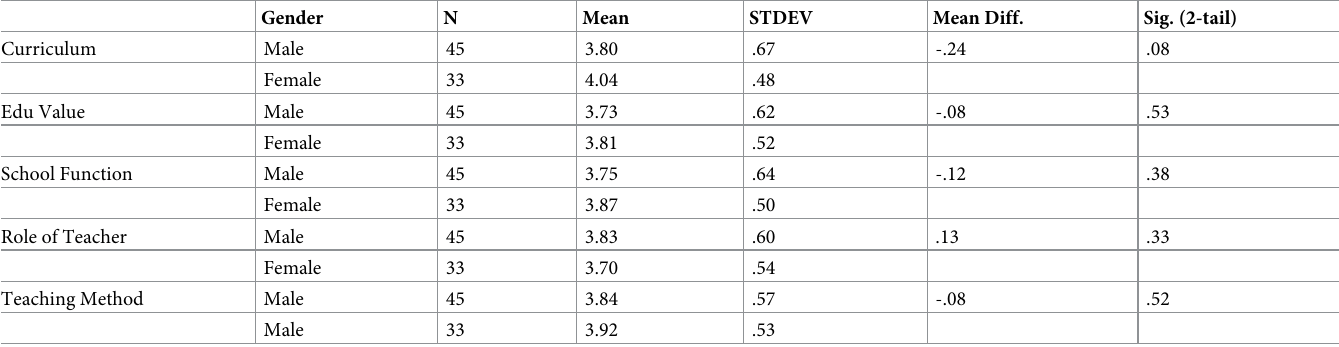
Table 9. Comparison of male and female teachers concerning the five categories.